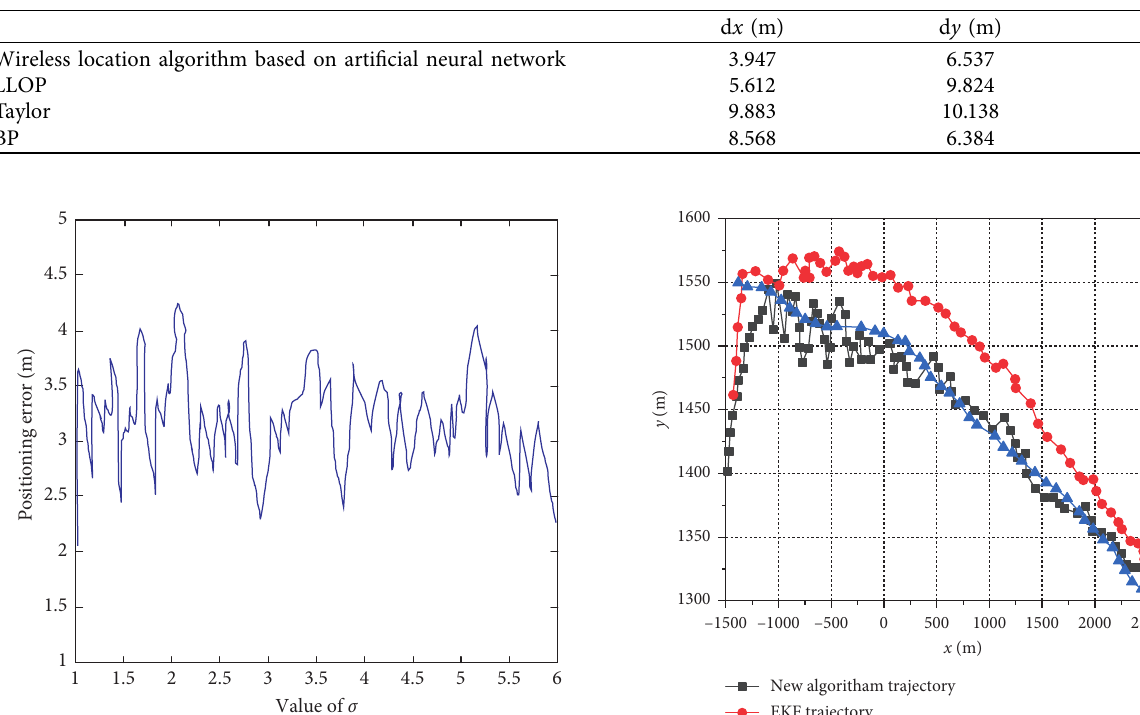
Table 1: Positioning deviation of different algorithms.